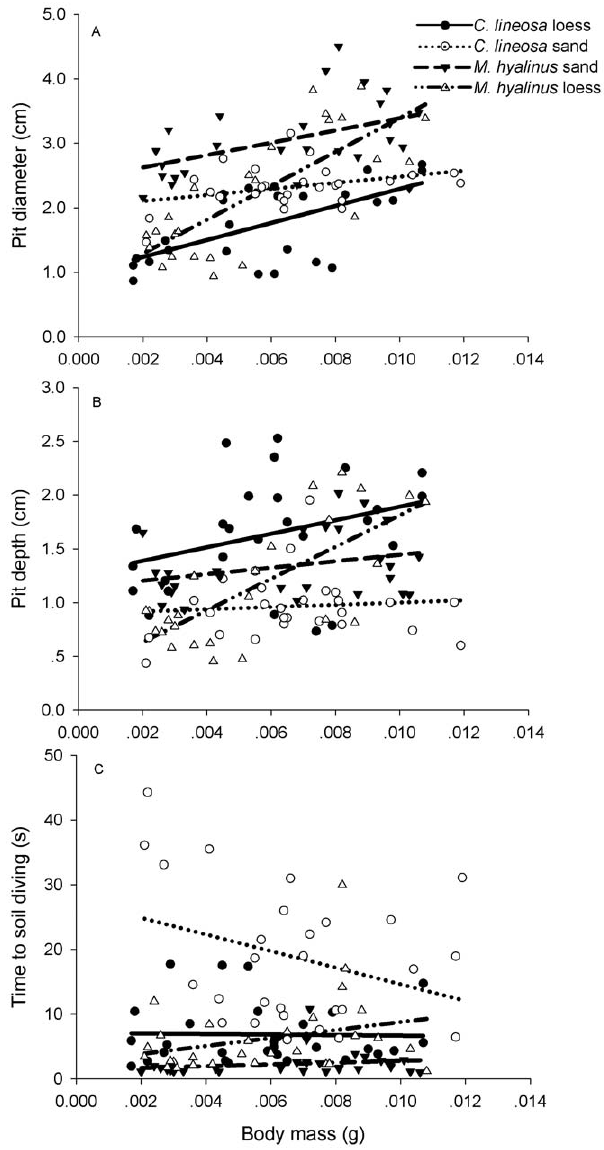
Figure 2. Pit diameter (A), pit depth (B), and time to soil diving (C) of both antlion species in the two soils as functions of their body masses. Both antlion species constructed pits with larger diameters in the sand than in the loess. M. hyalinus pits were larger than those of C. lineosa , irrespective of soil type (R 2 =0.625). Loess pits of C. lineosa were deeper than those of M. hyalinus , but the sand pits of the latter were deeper than those of the former (R 2 =0.436). M. hyalinus dives into the soil faster than C. lineosa , but this pattern is evident only in the sand (R 2 =0.612).